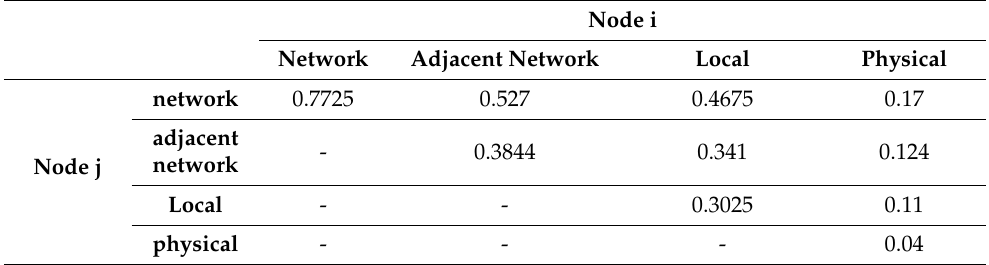
Table 2. Access location weight based on associations between two